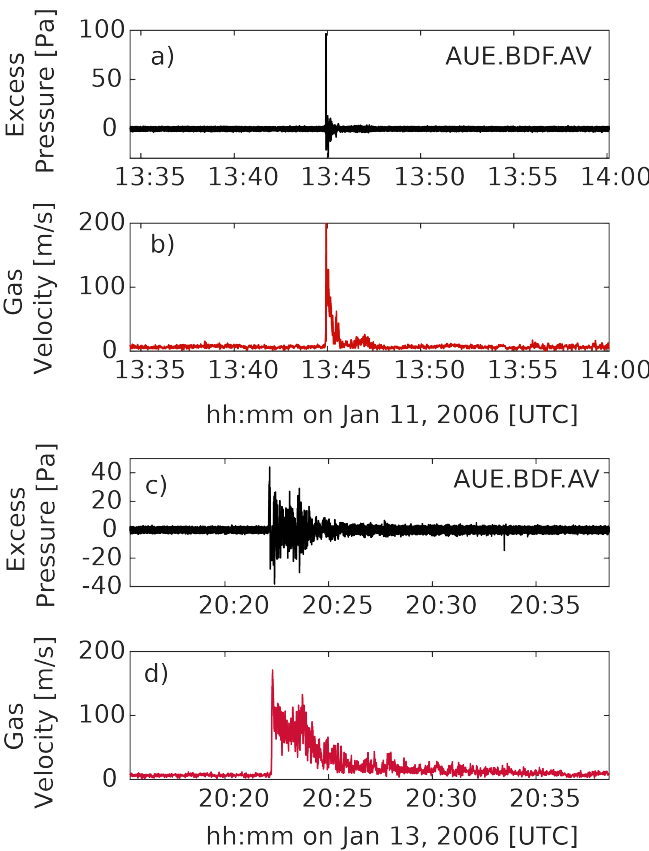
Figure 3. Infrasound-derived time series of gas velocity for two explosions during the 2006 eruption of Augustine volcano, USA: ( a , c ) Raw infrasound of explosive events on 11 January 2006 and 13 January 2006, respectively. Signals recorded by a microphone at 3.2 km from the vent. ( b , d ) Five-second moving-window gas velocity time series obtained by inverting Equation (2), assuming a dipole acoustic source. The figure reproduces results originally presented in Caplan-Auerbach et al.